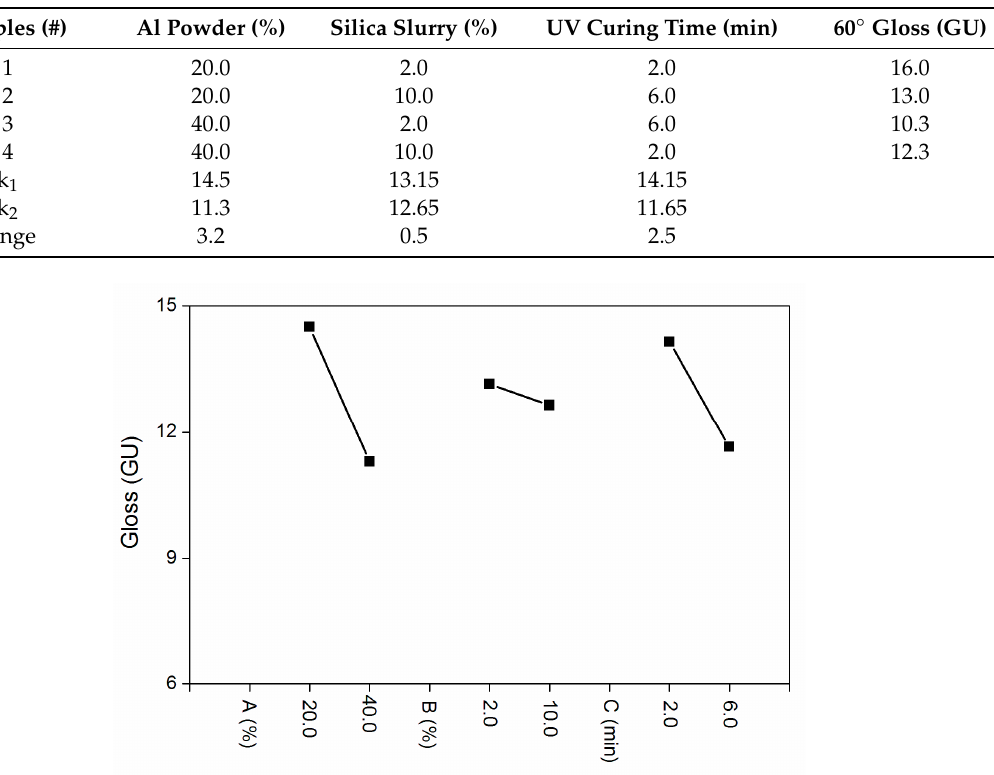
Figure 1. Orthogonal experimental e ff ects of the ( A ) Al powder, ( B ) silica slurry concentration and ( C ) UV drying